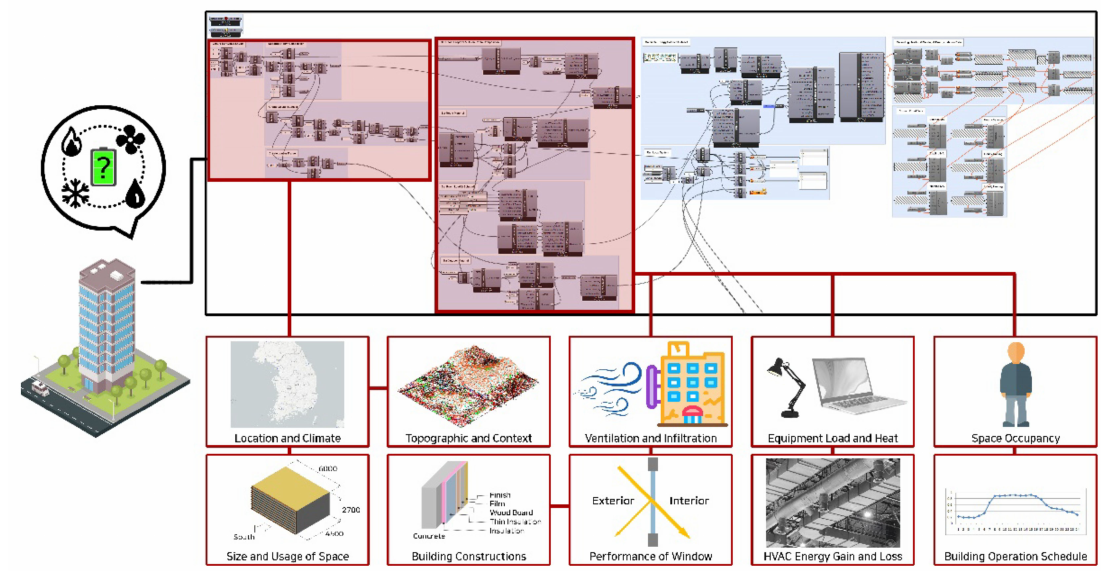
Figure 3. Factors influencing the calculation of heating and cooling